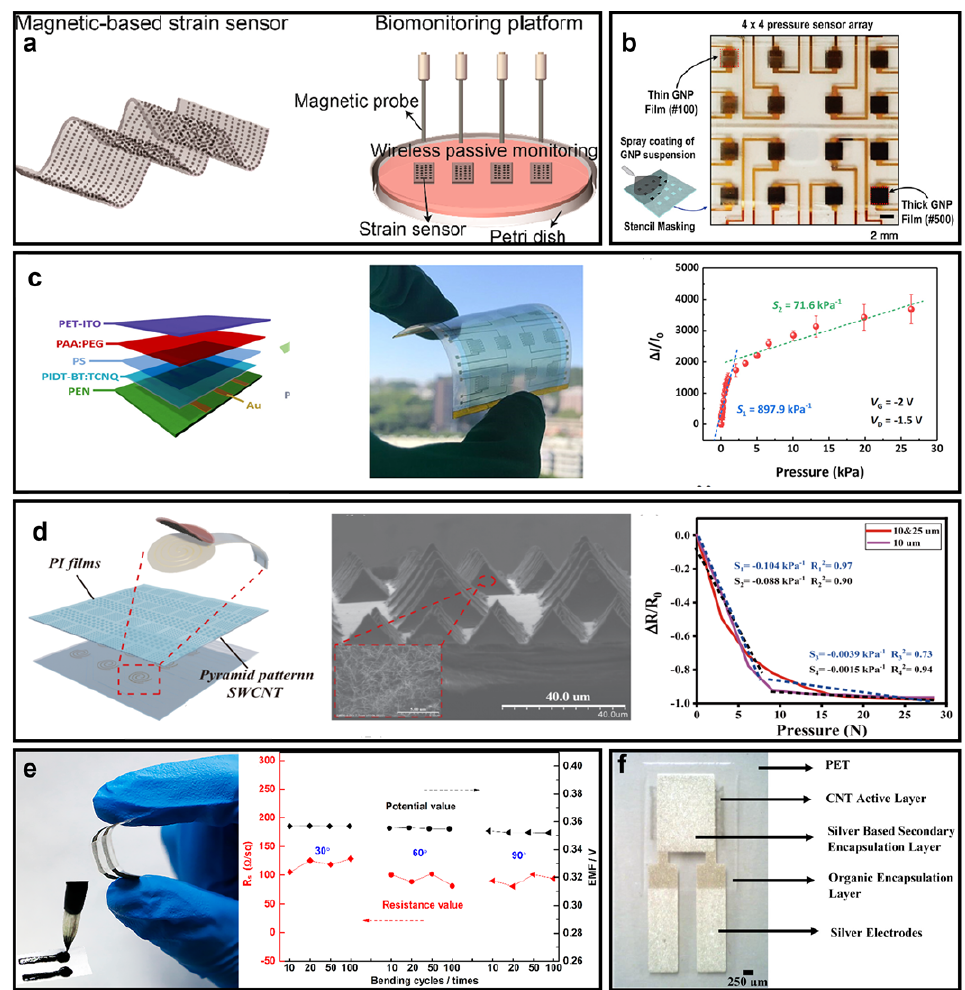
Figure 5. ( a ) A strain transducer based on (GelMA)/Fe 3 O 4 –magnetic hydrogel film (reprinted with